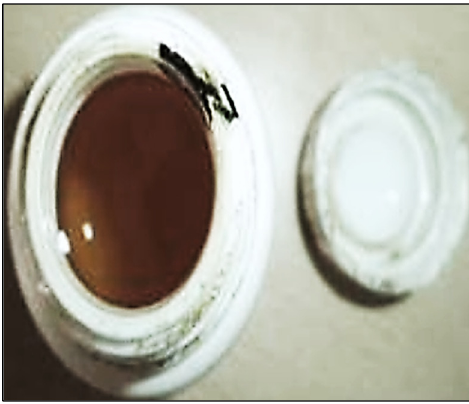
Figure 5. ZycoTherm additive. Table 9. The physical properties of ZycoTherm.